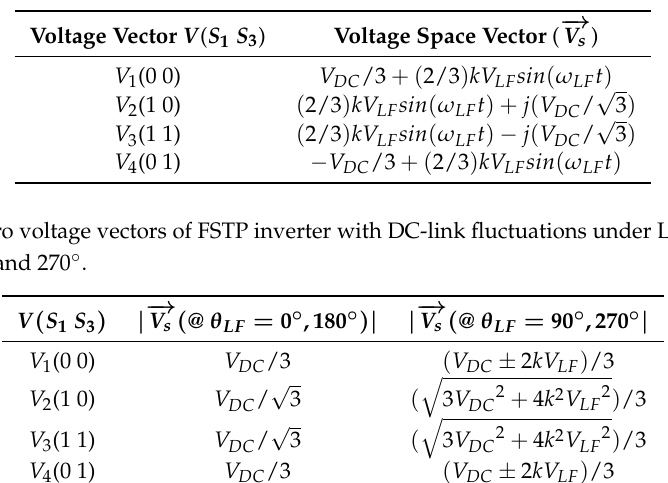
Figure 3. Block diagram of the proposed LFS injection based zero angle initial rotor position alignment for FSTP inverter-fed PMSM drives. Table 1. Non-zero voltage vectors of FSTP inverter with DC-link fluctuations under LF signal injection.